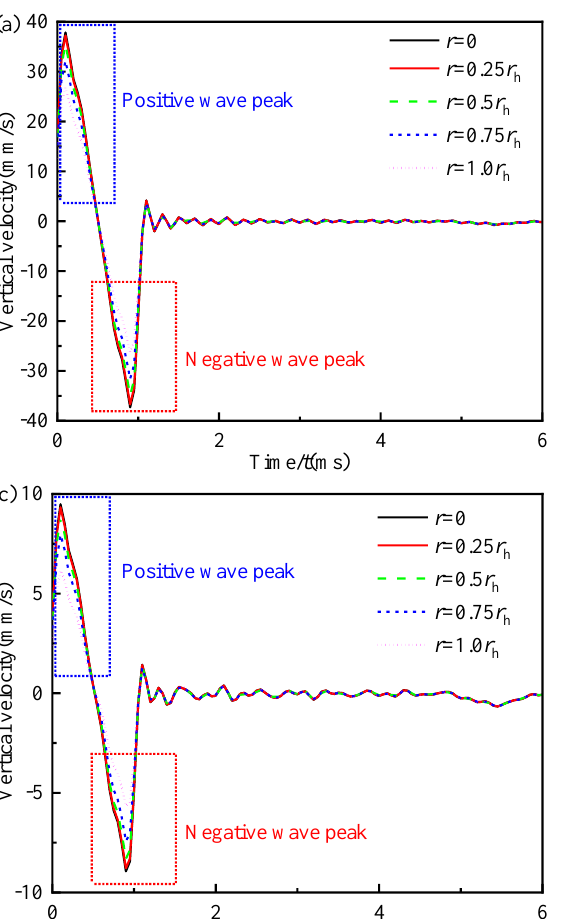
Figure 6. Velocity response in time domain of different test points along the radial direction within the excitation region for pile with R = 0.5 m: ( a ) r h = 0.01 m; ( b ) r h = 0.02 m; ( c ) r h = 0.04 m; ( d ) Variation of the negative-positive-ratio.